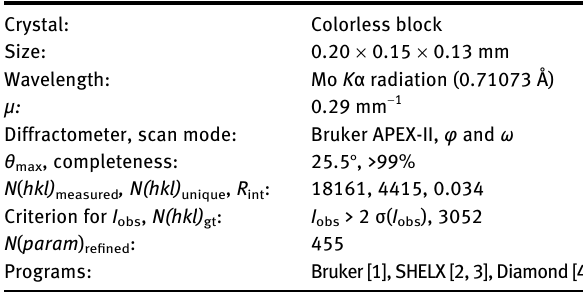
Table  : Data collection and